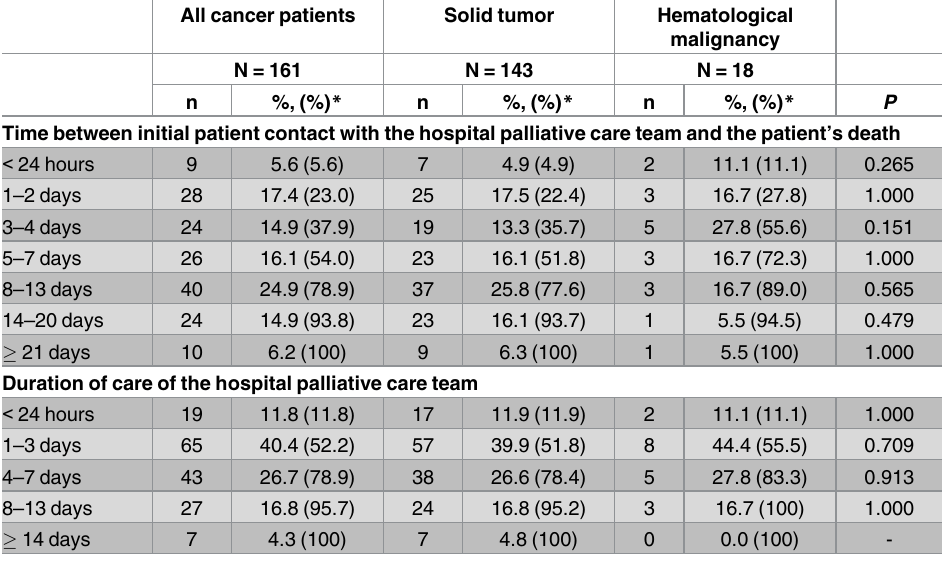
Table 9. Cancer patients, who had contact with the hospital palliative care team before death. All cancer patients Solid